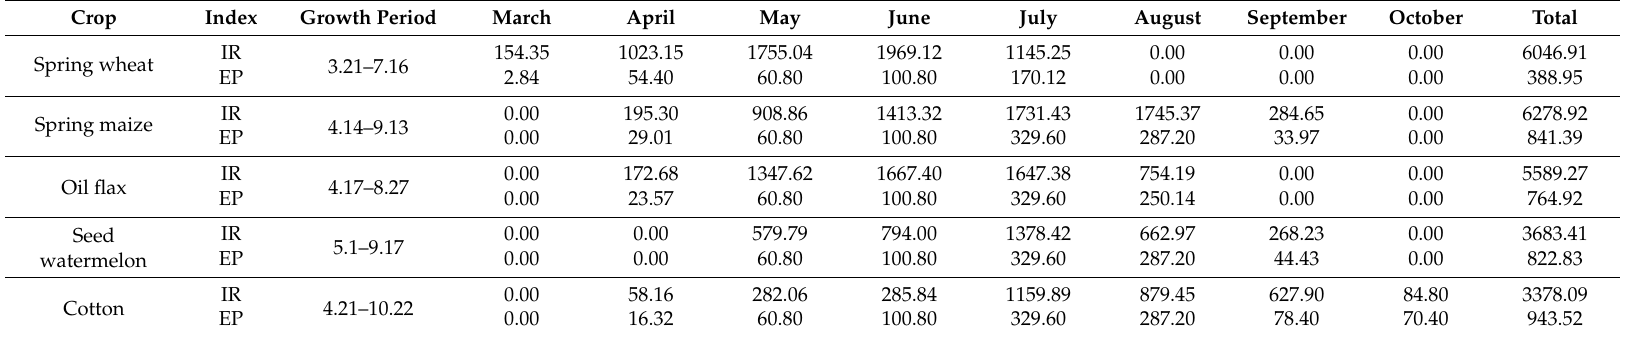
Table 2. Irrigation requirement (IR) and effective precipitation (EP) for different crops m 3